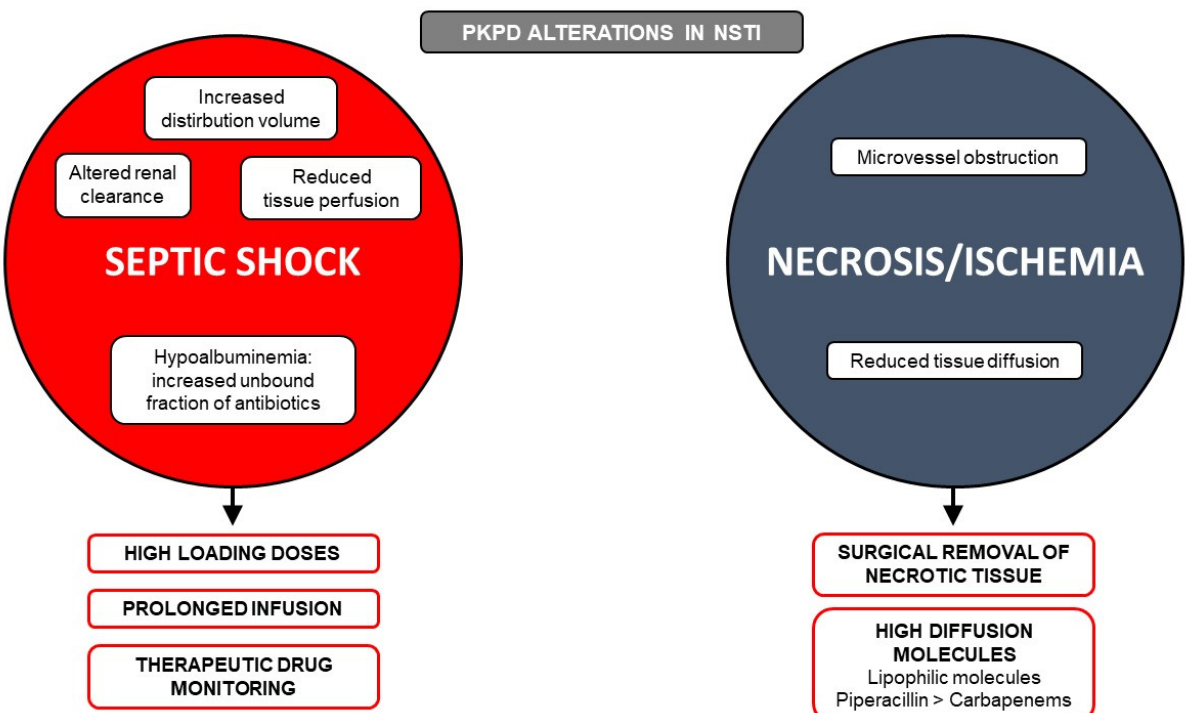
Figure 1. Pharmacokinetic (PK) and pharmacodynamic (PD) alterations in patients with necrotizing soft tissue infection (NSTI). Features of septic shock from any cause (increased distribution volume, altered renal clearance, hypoalbuminemia, and reduced tissue perfusion) abound for optimizing delivery of hydrophilic and time-dependent drugs such as beta- lactams by using high-loading doses and prolonged infusion with therapeutic drug monitoring. Specificities of NSTI with tissue necrosis and local ischemia resulting in hindered tissular diffusion are consistent with the need for urgent and aggressive surgical debridement of necrotic tissues. Molecules with higher tissue diffusion, such as lipophilic molecules ( e.g. , clindamycin, linezolid and daptomycin), might be of interest in this setting.